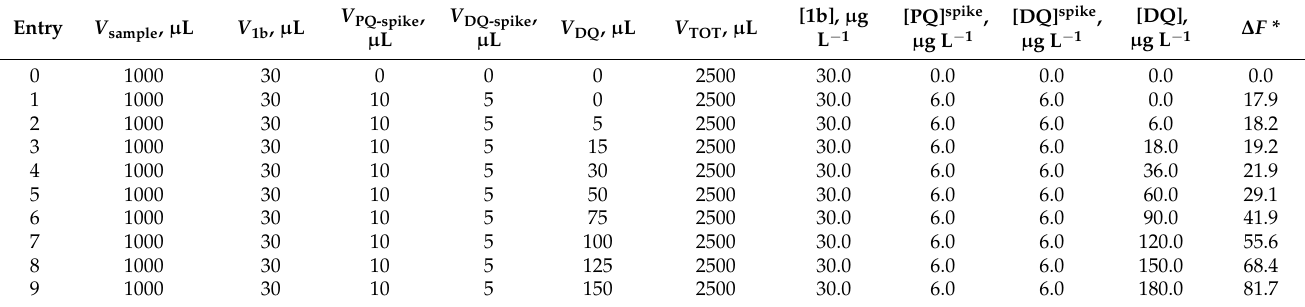
Table 12. Experimental data for the evaluation of cross-interferences by using the standard addition method. V 1b , V DQ and V PQ are the added volumes of the standard methanol solutions of [1b] = 2500 µ g L − 1 , [DQ] = 3000 µ g L − 1 and [PQ] = 1500 µ g L − 1 , respectively. V PQ-spike and V DQ-spike are the volumes added to a tap water sample to spike it at the concentration of 6.0 µ g L − 1 .